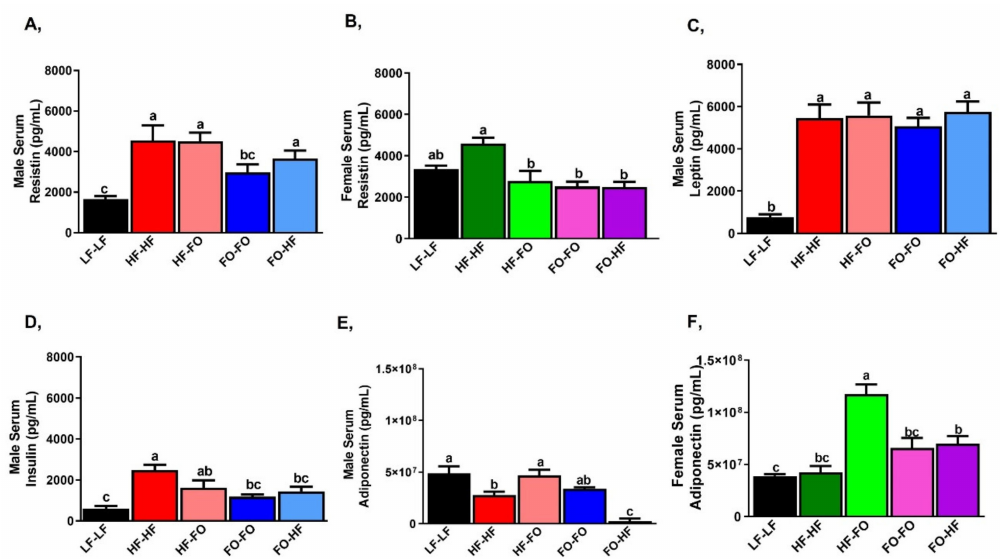
Figure 5. Fish oil supplementation alters adipokines in serum of male and female mice: ( A ) Serum resistin levels in male mice. ( B ) Serum resistin levels in female mice. ( C ) Serum leptin in male mice ( D ) Serum insulin levels in male mice. ( E , F ) Serum adiponectin levels in both males and females. Data is presented as mean ± SEM (n = 8). Common letters on the error bars indicate no significance (e.g., “a” is significantly different from “b” and “ab” indicates no significance compared to “a” and